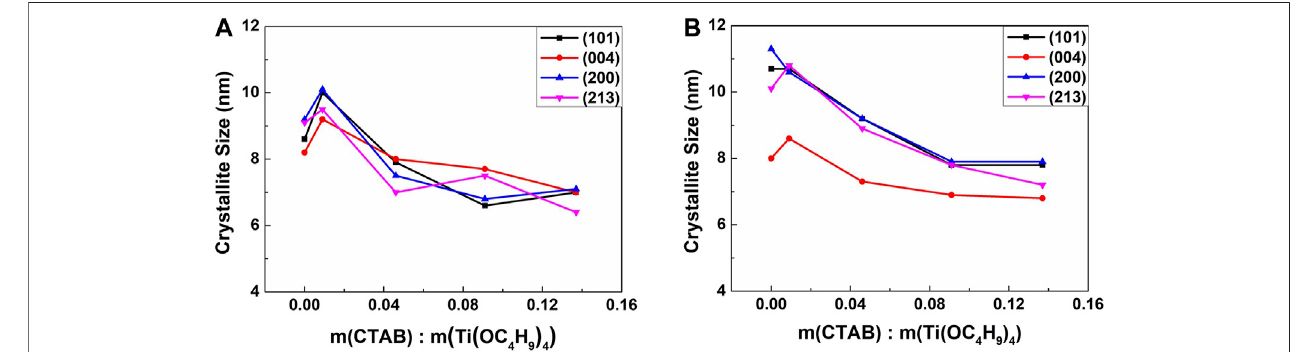
FIGURE 7 | Crystallite size analysis of (A) TiO 2 aerogels without the calcination, (B) 300 ° C-calcined TiO 2 aerogels.